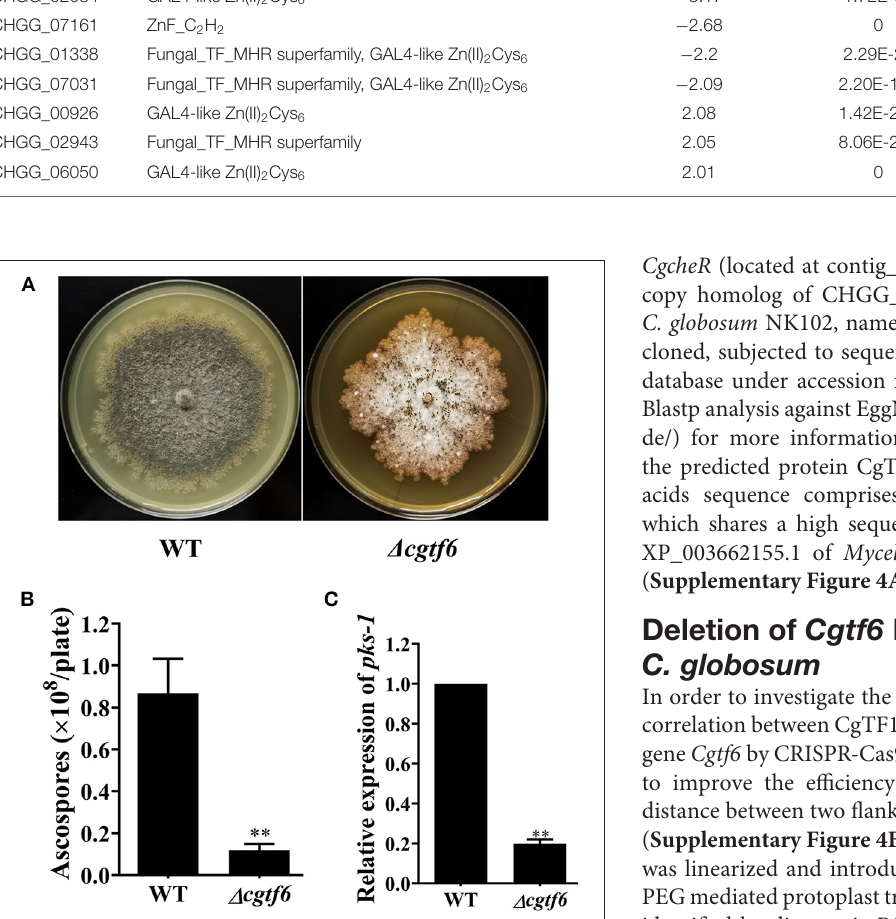
FIGURE 5 | CgTF6 deletion severely inhibited sexual development of C. globosum. (A) CgTF6 deletion severely inhibited perithecium formation. (B) The number of ascospores produced by the wild-type (WT) and ∆ cgtf6. The indicated strains were inoculated in the PDA plate and incubated at 28 ◦ C for 15 days. (C) Gene expression of pks-1 in WT and ∆ cgtf6 . Transcripts of pks-1 was normalized against GAPDH . All experiments were performed in triplicate. There is significantly difference between the WT and ∆ cgtf6 as indicated by two asterisks ( p -value < 0.01, with T -test